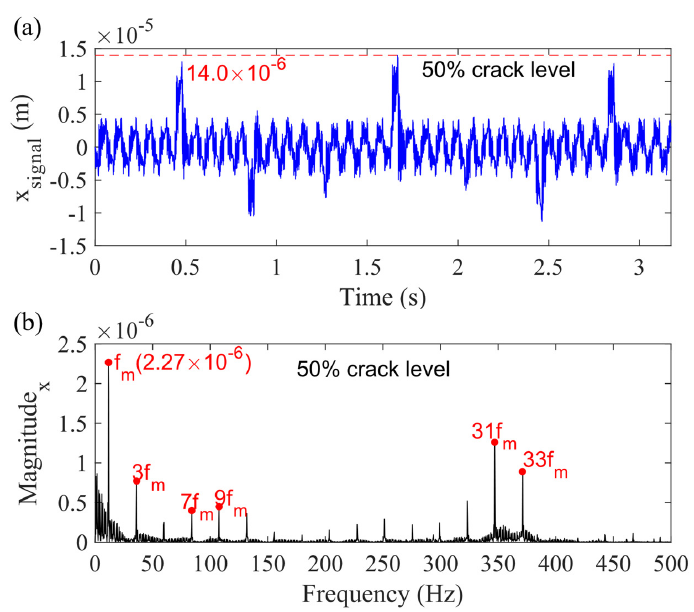
Figure 12. Sum vibration response for 50% sun gear crack level for Case 2 in ( a ) time domain and ( b ) frequency domain, in x g -direction.